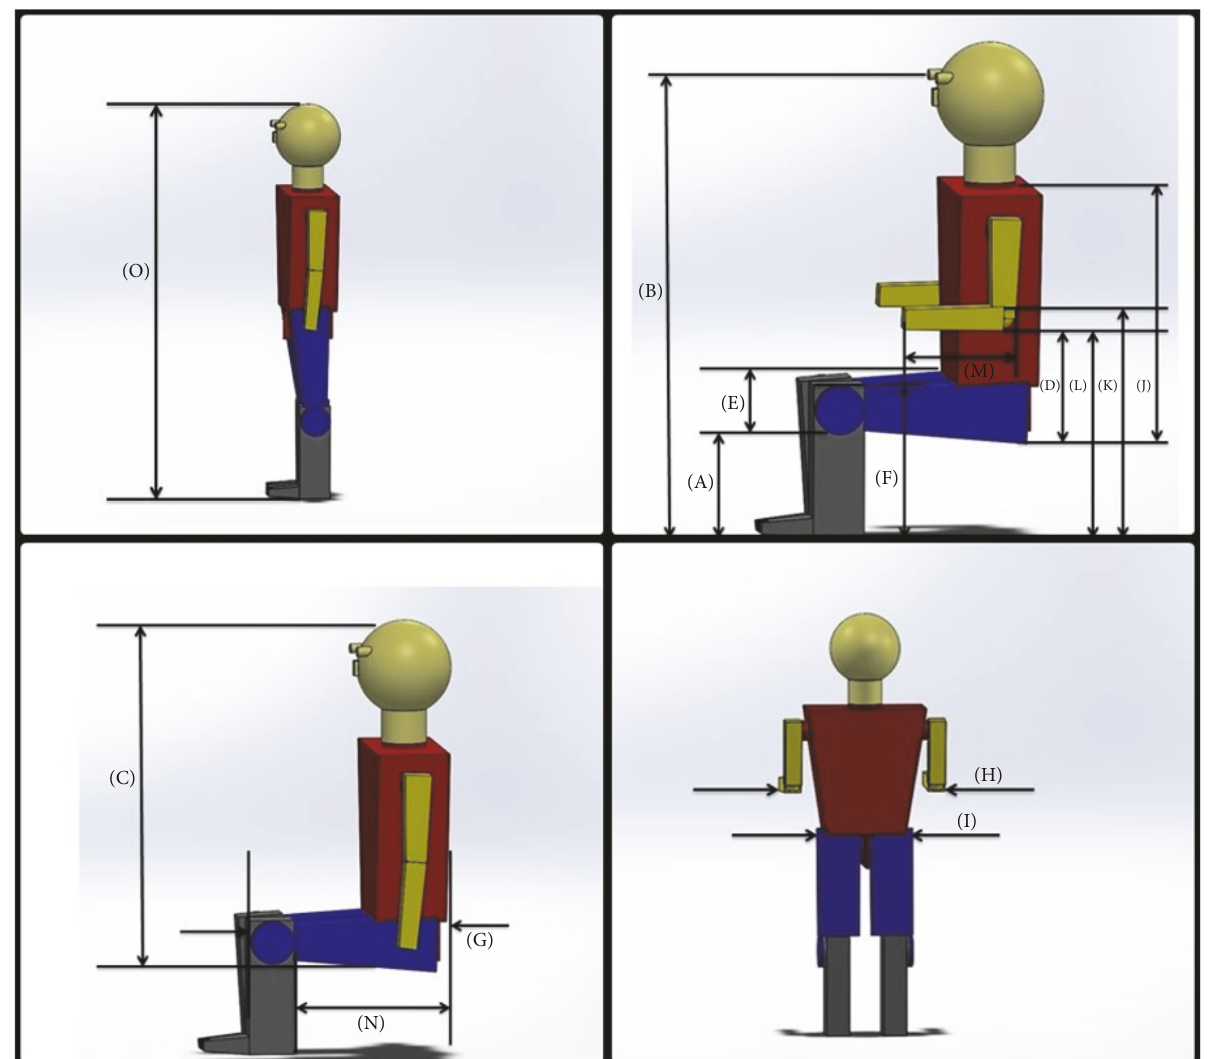
Figure 1: Anthropometric measurements of human body. (A) Popliteal height, (B) sitting eye height, (C) sitting height, (D) sitting elbow height, (E) thigh clearance, (F) knee height, (G) buttock knee length, (H) elbow to elbow breadth, (I) hip breadth, (J) sitting shoulder height, (K) sitting lowest rib bone height, (L) sitting upper hip bone height, (M) forearm fingertip length, (N) buttock popliteal length, and (O)